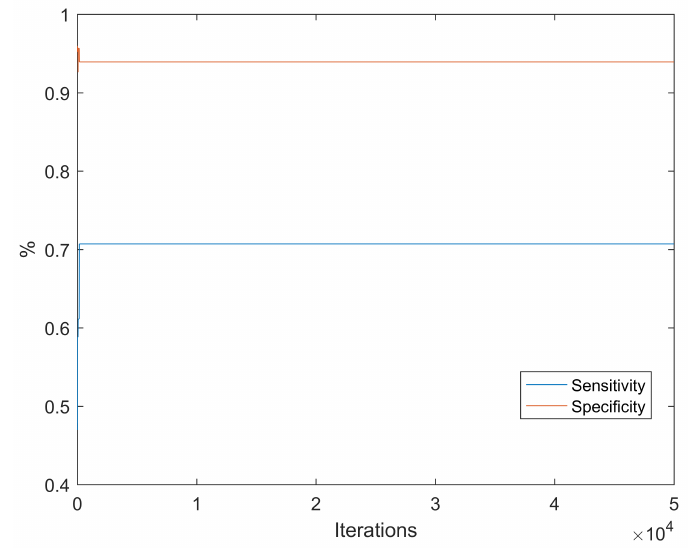
Figure 6. Sample of asymptotic analysis (50,000